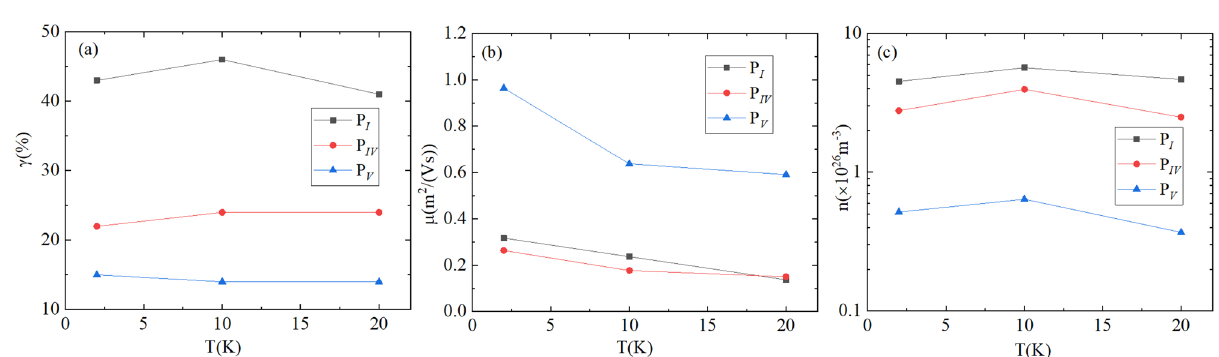
Figure 3. The ratio of ( a ) conductivity contribution γ , ( b ) mobility µ , and ( c ) carrier concentration n as a function of temperature T for P I (black squares), P IV (red circles), P V (blue triangles),